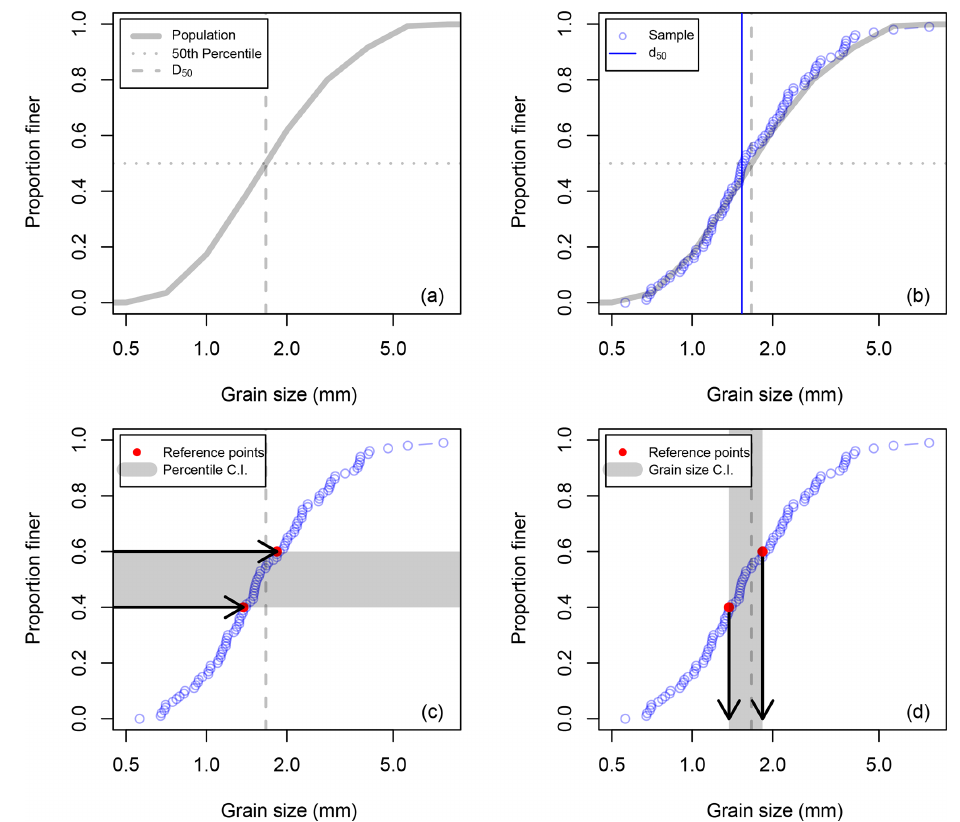
Figure 2. Defining the relation between the percentile confidence interval (C.I.) and the grain size confidence interval for a sampled d 50 value. (a) Begin with the known distribution for the population being sampled, with a vertical line indicating the true D 50 . (b) Derive a sample distribution from 100 measurements from the population shown in panel (a) (note that the sample d 50 and the population D 50 are different). (c) Use binomial theory to estimate the percentile confidence interval that contains the population D 50 . (d) Map the percentile confidence interval onto the sample cumulative frequency distribution to estimate the grain size confidence interval around the sample estimate, d 50 (note that the confidence interval does indeed contain the true D 50 for the